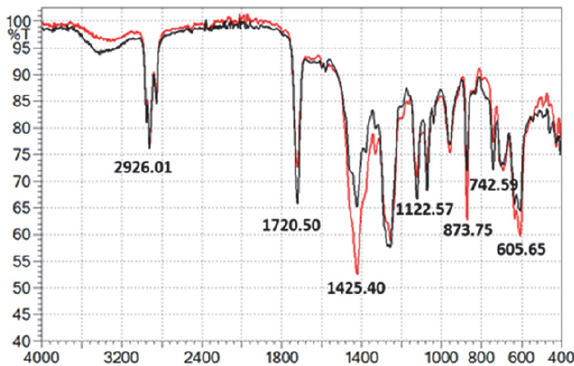
Figure 8. FTIR spectra at the back side of the plasticized mem- branes (black line) and aged membranes (red line) operating in at- tenuated total reflection (ATR)